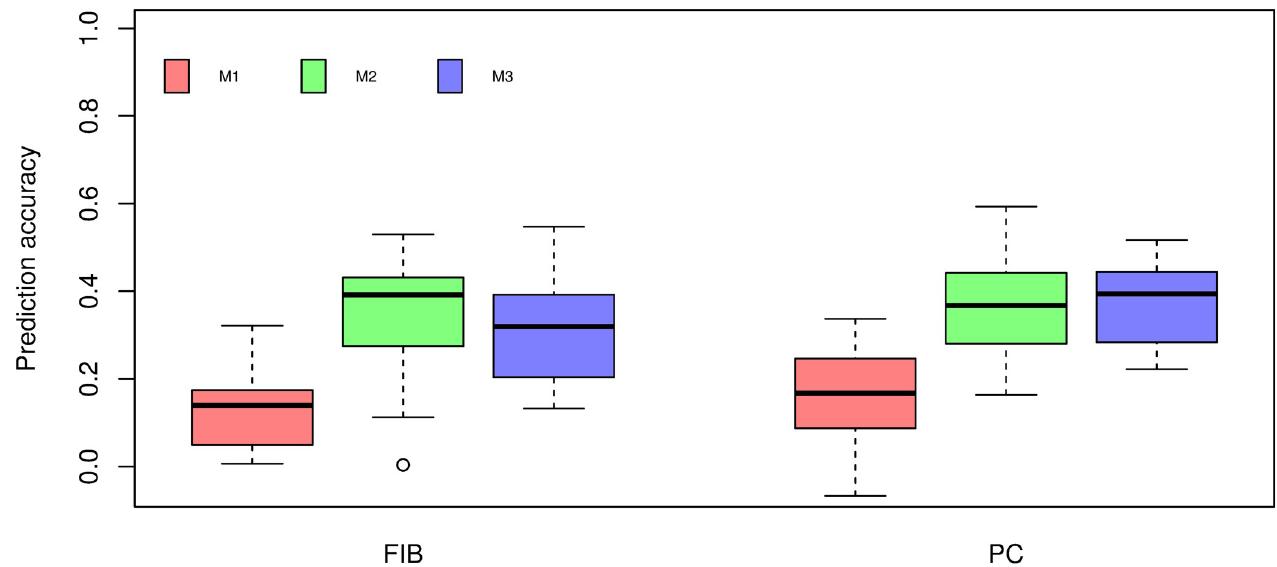
Fig 5. Box-plot of cross-validation prediction accuracy of fiber content (FIB) and sucrose content (PC) using PLS under three different prediction models. M1: Markers. M2: Near-infrared spectra. M3: The combination of markers and near-infrared spectra. Different lowercase letters denote significant differences with Tukey’s test ( P <